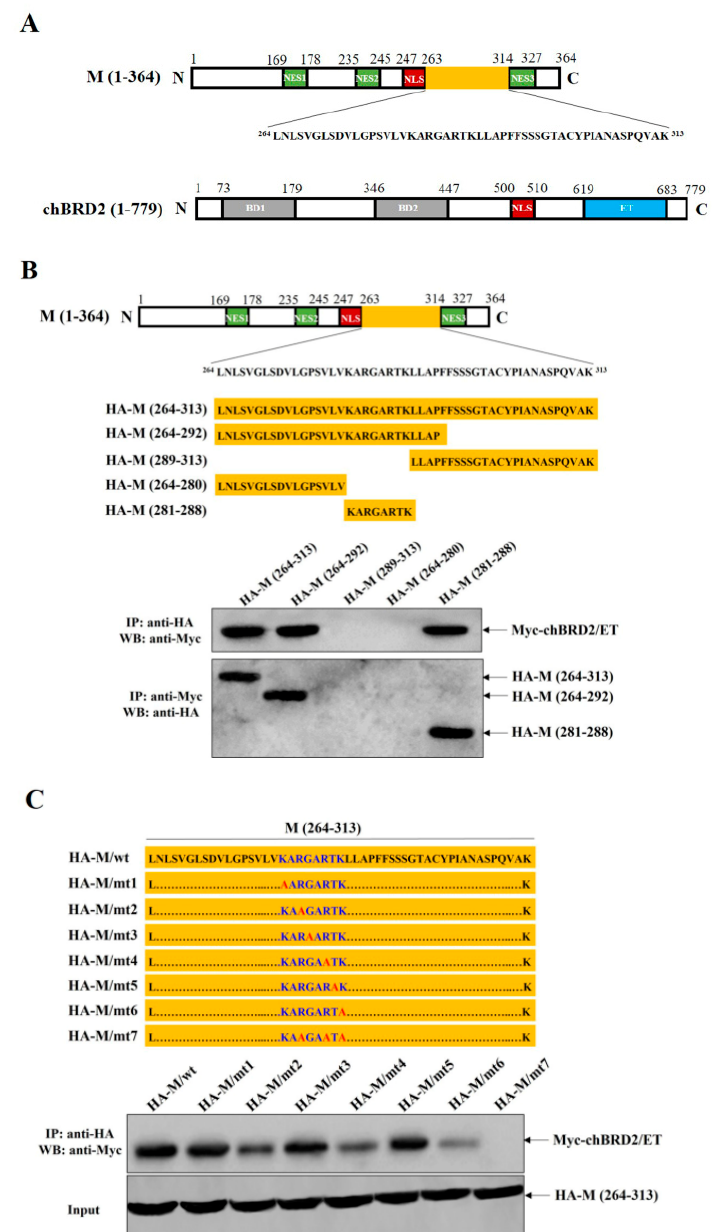
Figure 1. Basic residues R283, R286, and K288 of M protein are crucial for its interaction with chBRD2/ET. ( A ) Schematic diagram of NDV M protein and chBRD2. NLS, nuclear localization signal; NES, nuclear export signal; BD, bromodomain; ET, extra-terminal domain. ( B ) Characterization of the shortest amino acid region in the C-terminus (aa 264–313) of M protein interacting with chBRD2/ET. ( C ) Characterization of the key residues in the aa 281–288 of M protein that interacts with chBRD2/ET.